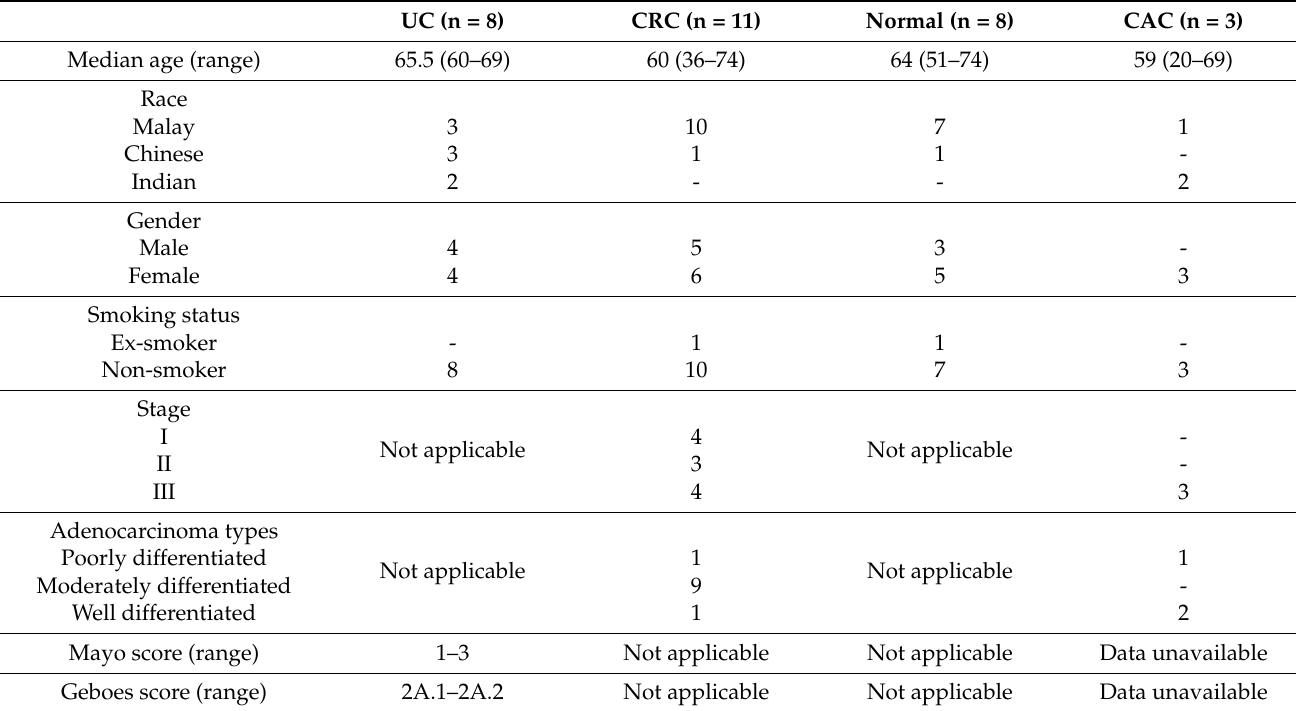
Table 1. Clinical and demographic details of the recruited patients. All data are expressed as n except where indicated in the table. UC, ulcerative colitis; CRC, colorectal cancer; CAC, colitis-associated cancer; n,